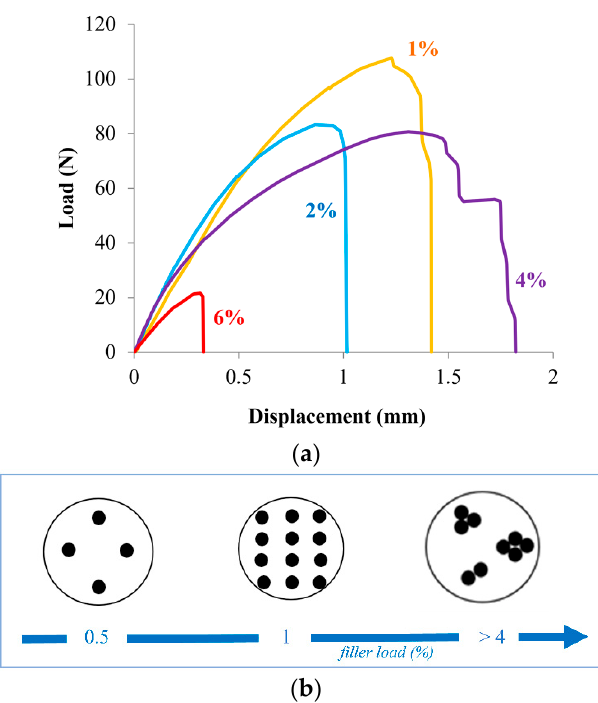
Figure 3. Load-displacement representative curves of the joints with different TiO 2 amounts ( a ). Possible filler distribution within the polymeric matrix at different filler amounts ( b ).